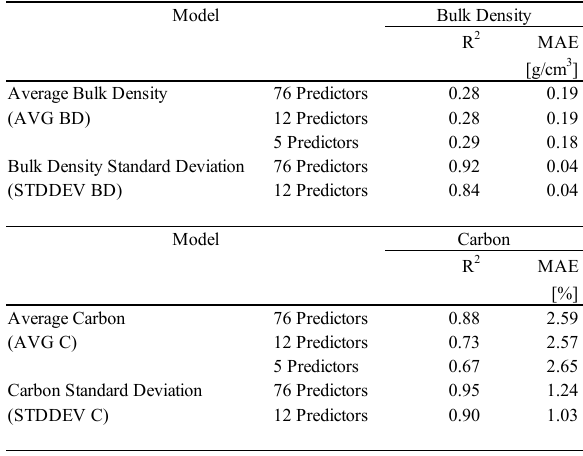
Table 2. Accuracies for RF models for each target variable (AVG BD, STDDEV BD, AVG C and STDDEV C) for the 0- Figure 3. Variable importance of the predictors for the RF 15 cm depth layer. models for AVG C for the 0-15 cm depth layer.